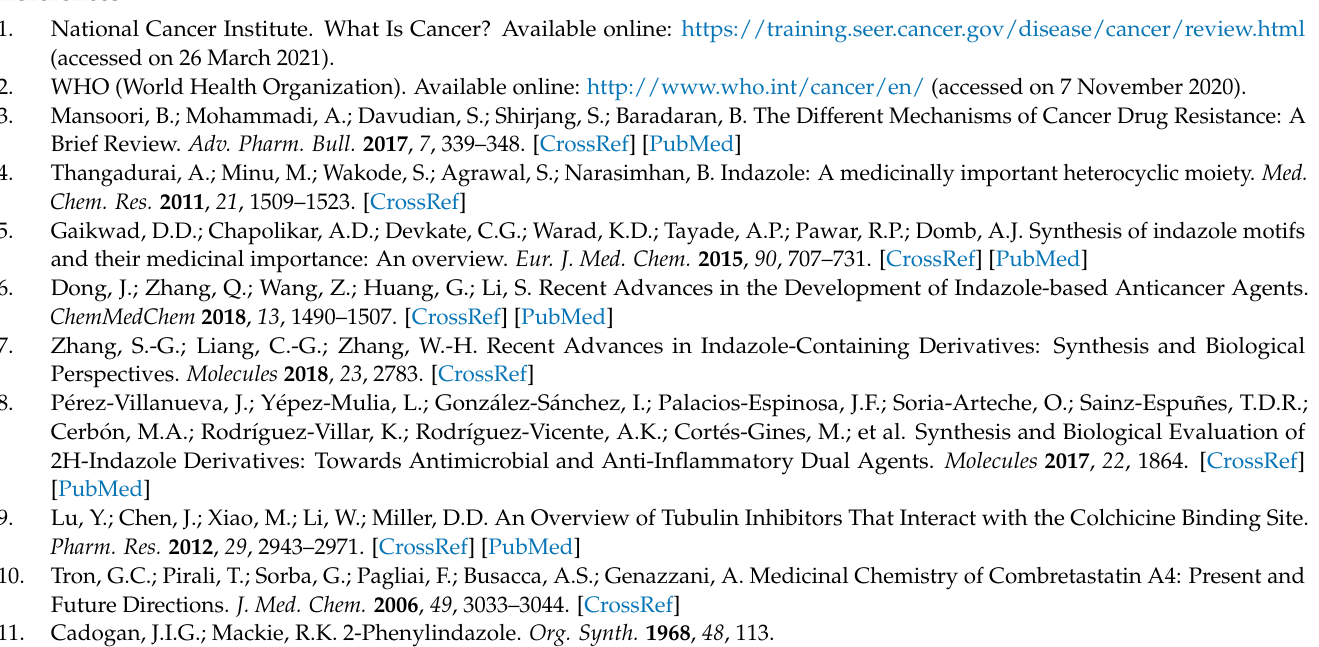
for synthesized compounds, Figure S30: Morphological changes of HeLa cells after 48 h of treatment, Figure S31: Quantitative apoptosis assay of HeLa using Annexin